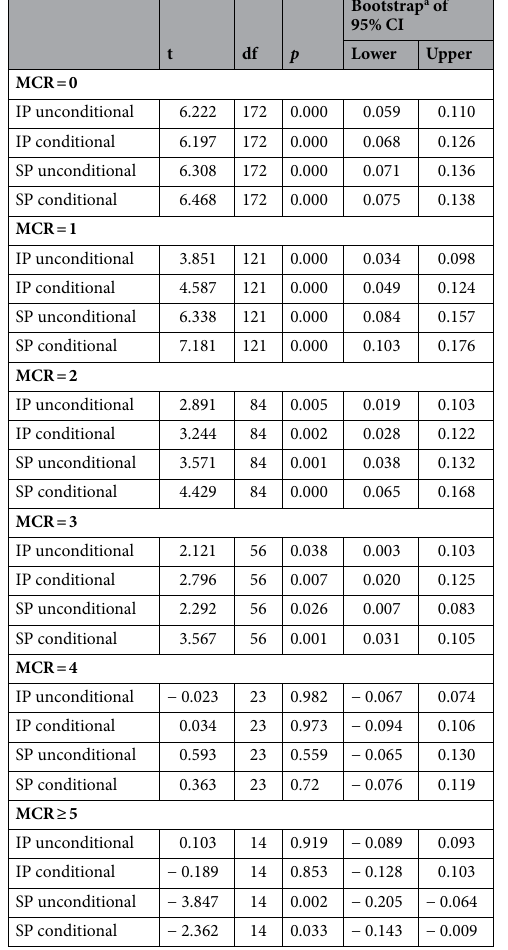
Table 3. One-Sample t-test of SIF on the SP and IP tests, according to compliance. One-sample t -tests compared to zero were used to identify when final recall on the various test measures reliably fellow below Baseline (indicating positive suppression-induced forgetting); MCR = Memory Checking Rating (total compliance score across questionnaire items); CI = Confidence Interval; bootstrap results are based on 1000 bootstrap